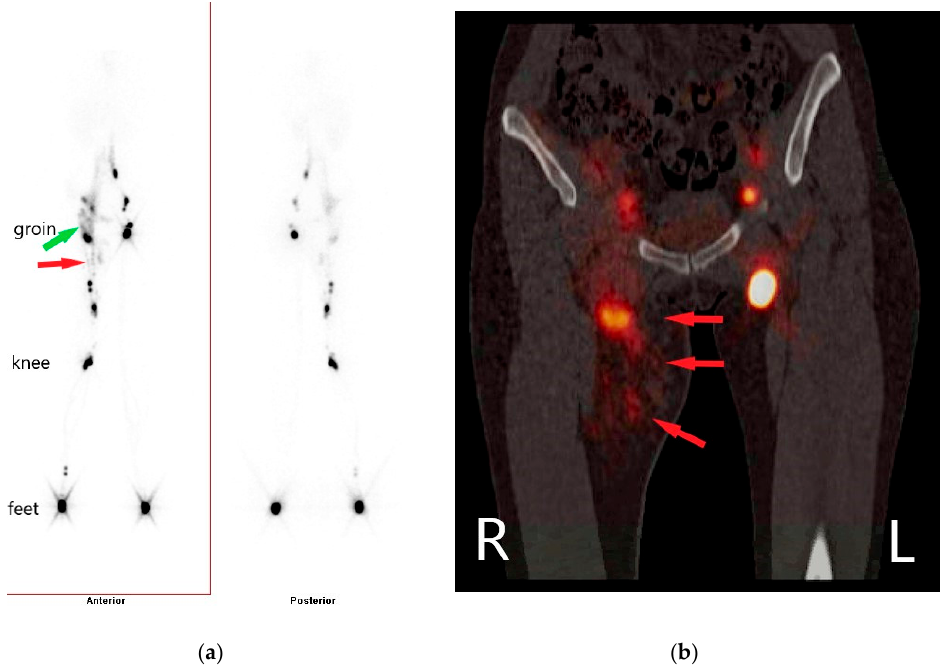
Figure 2. ( a ) Lymphoscintigraphy: uptake of radio-colloid tracer at the level of the right thigh (red arrow) and extending into the abdomen (green arrow). ( b ) Hybrid images of single photon emission tomography and computed tomography (SPECT-CT) and lymphoscintigraphy: visualization of radio-colloid tracer at the level of the right thigh pointing to the presence of lymphatic structures (red arrows).